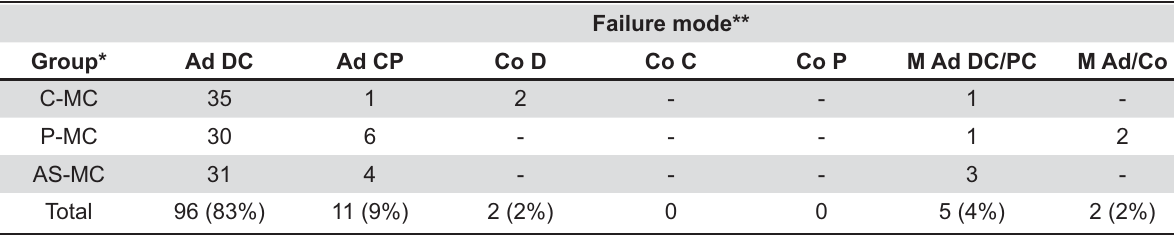
Table 2- Distribution of failure modes after the push-out test